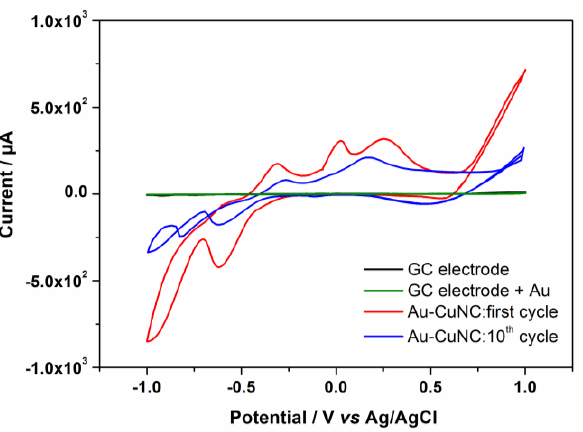
Figure 4. Cyclic voltammograms of GC electrode, GC electrode covered with a layer of gold, and the Au-CuNC electrode at 5 mV/s representing the 1st and 10th cycles in in 50 mM NaOH. The HR-STEM micrographs (see Figure 5) of the electrode exposed to ten cyclic voltam- mograms in 50 mM NaOH show that the CuNCs are covered by corrosion products [34]. The content of oxygen in the EDX analysis increases from 7 to 26 at.%. The film observed is crystalline, with an interplanar distance of 0.25 nm, assigned to the (111) orientation of Cu 2